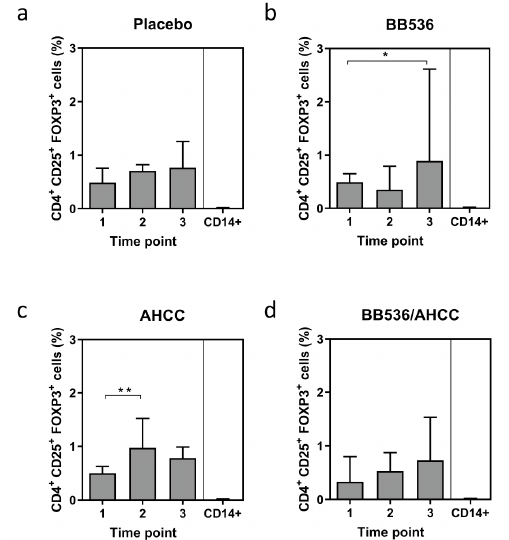
Figure 2. CD4 + CD25 + Foxp3 + cells (Tregs) as determined by cytometric bead array. X-axis represents different sampling time points during the study. Values represent mean (SEM). Significance calculated using the Student t test (paired). BB536: Bifidobacterium longum ; AHCC ® : a standardized